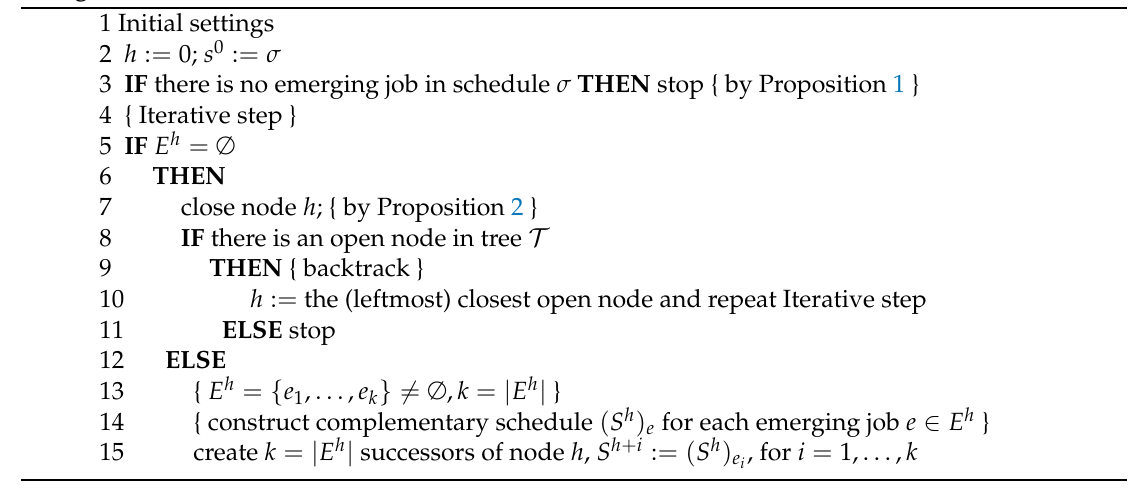
Algorithm 1: PROCEDURE Enumerate() {Generates tree T